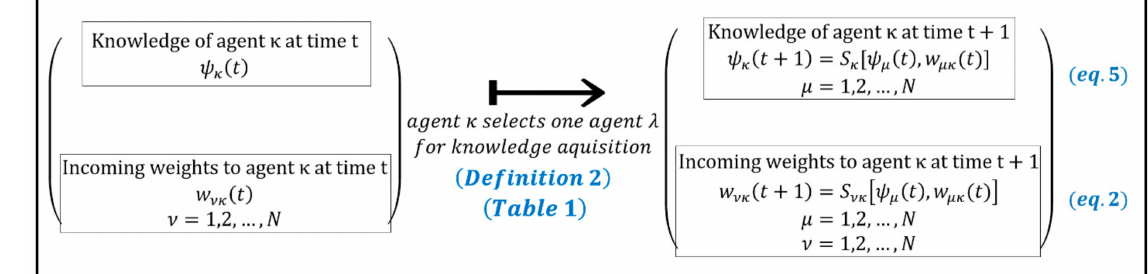
Figure 1. Local Mechanism for Interdependent Co‑evolution of weights and knowledge for each agent 𝜅 , 𝜅 = 1,2,…,𝑁 , at each time 𝑡 = 0,1,2,… Knowledge and weights co‑evolve, because the change of knowledge and weights depends on the values of both knowledge and weights at the previous step. This interdependence of knowledge and weights is conditioning the network evolution at each step.